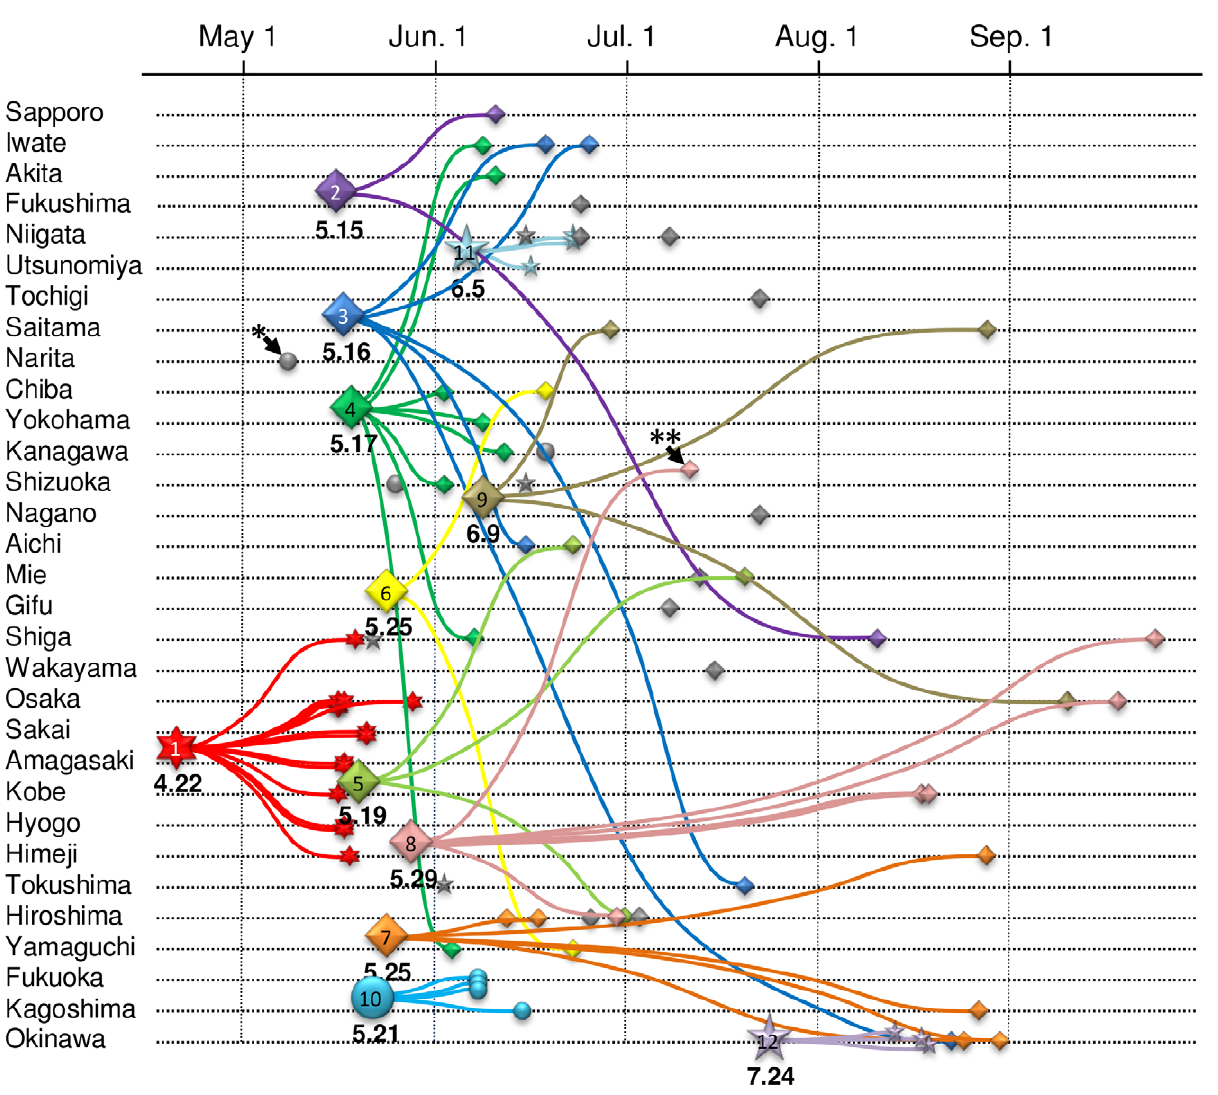
Figure 4. Schematic representation of the estimated profile of A(H1N1)pdm epidemic in Japan. The vertical and the horizontal axes show geographic localities and the times of viruses collection, respectively. The geographic localities are aligned in order of their latitude and the longitude as north-east to south-west. Seventy-five isolates of A(H1N1)pdm viruses from Japan are plotted by small symbols. The most recent common ancestor of twelve micro-clades inferred from the analysis are plotted by large symbol. Shape of the symbols indicate the cluster of each virus belonged; circle shows cluster 1, lozenge shows cluster 2, six-pointed star shows cluster 1.2 and five-pointed star shows cluster 1.3. The number below the large symbol shows tMRCA date. The number in the large symbol shows the micro-clade. The member of each micro-clade and their MRCA are linked with curves using different colors. The viruses which cannot classify any micro-clades are represented by gray symbols. A virus with a single asterisk is Narita/1 that was the first confirmed case in Japan. A virus with a double asterisk is A/Japan/PR1070 that had no epidemiological information.